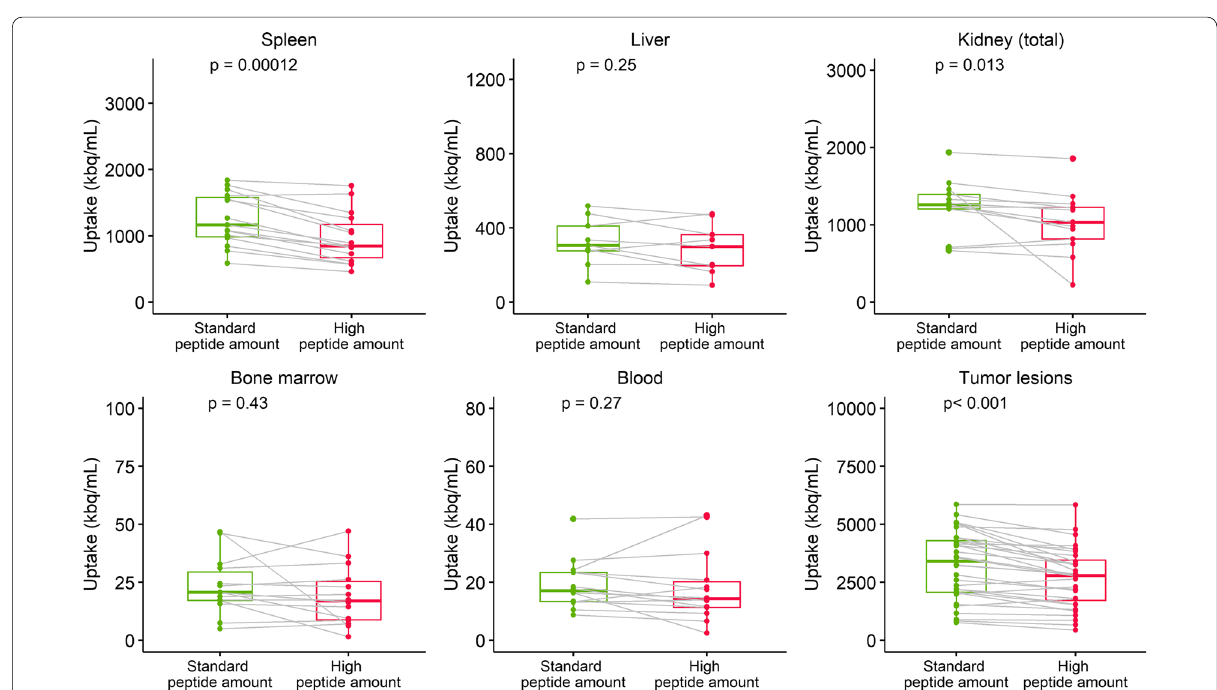
Fig. 2 Results from paired Wilcoxon analyses of organ and tumor uptake differences between standard and high administered peptide amount of [ 177